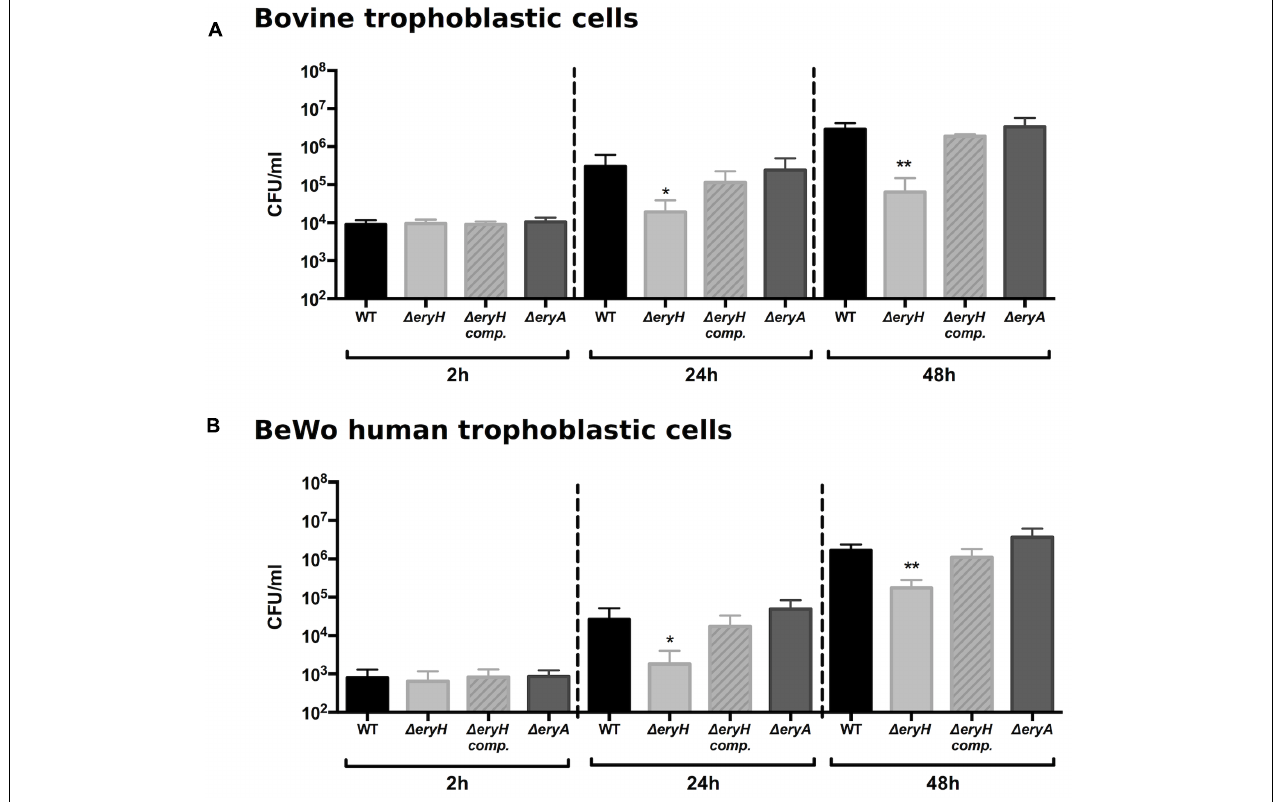
FIGURE 2 | Brucella abortus (cid:49) eryH but not B. abortus 2308 (cid:49) eryA or the complemented B. abortus (cid:49) eryH ( eryH comp.) are attenuated in bovine (A) and human trophoblastic (B) cells. Values are the average of biological and technical triplicates plus the standard deviation ( ∗ p < 0.05; ∗∗ p < 0.01; ∗∗∗ p < 0.001 [Student’s t